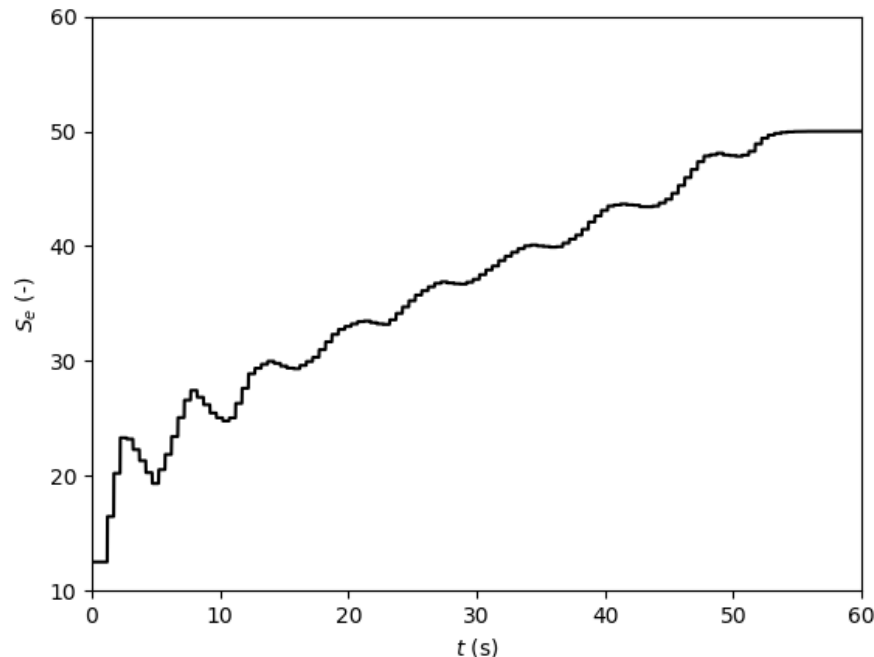
Figure A7. Effective swirl number profile, feedback with downgraded regulation law, case 1.